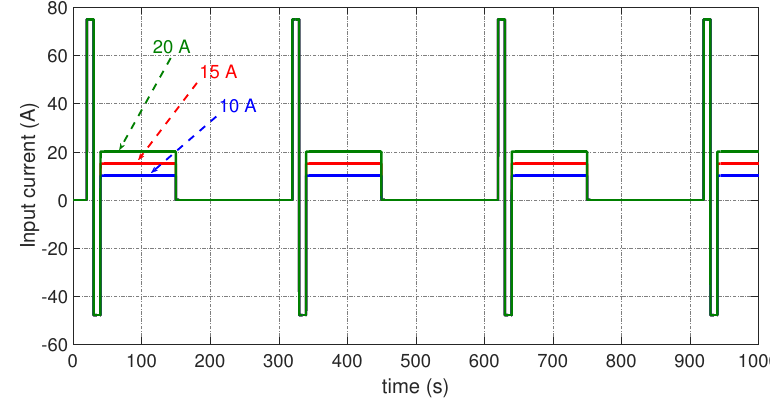
Figure 8. Three different input currents for the